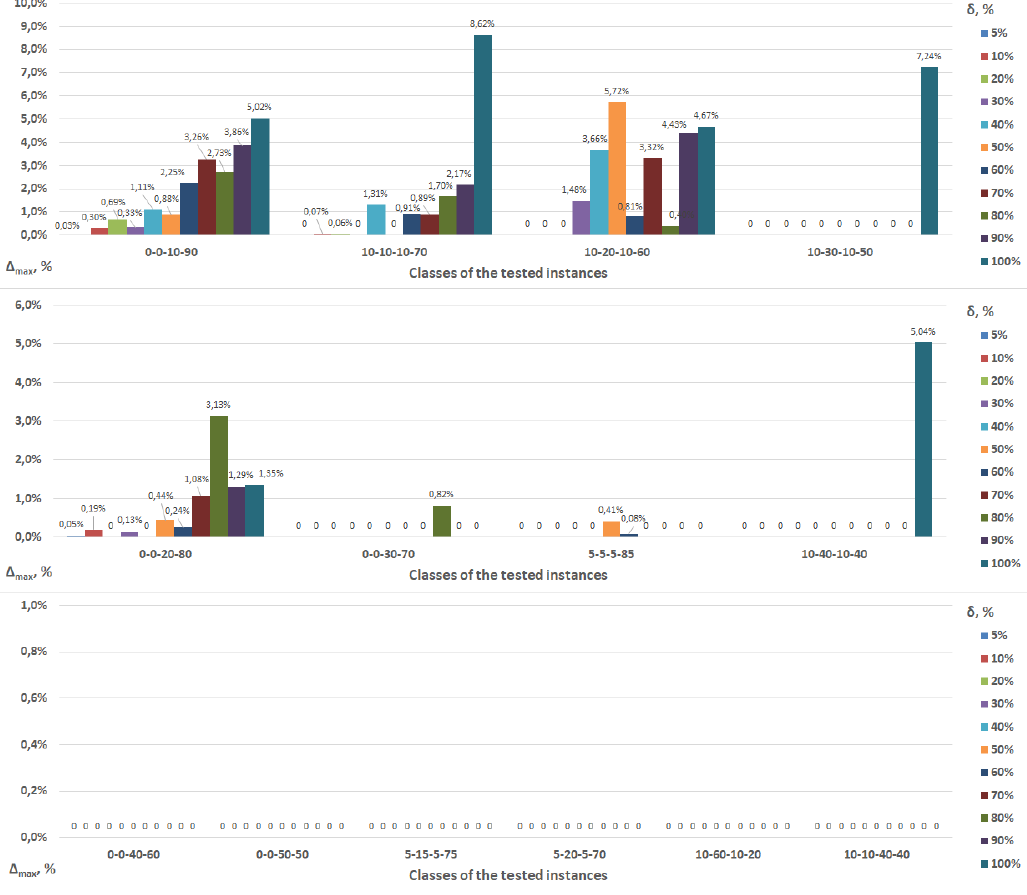
Figure 7. Maximal errors ∆ max for the tested instances with a uniform